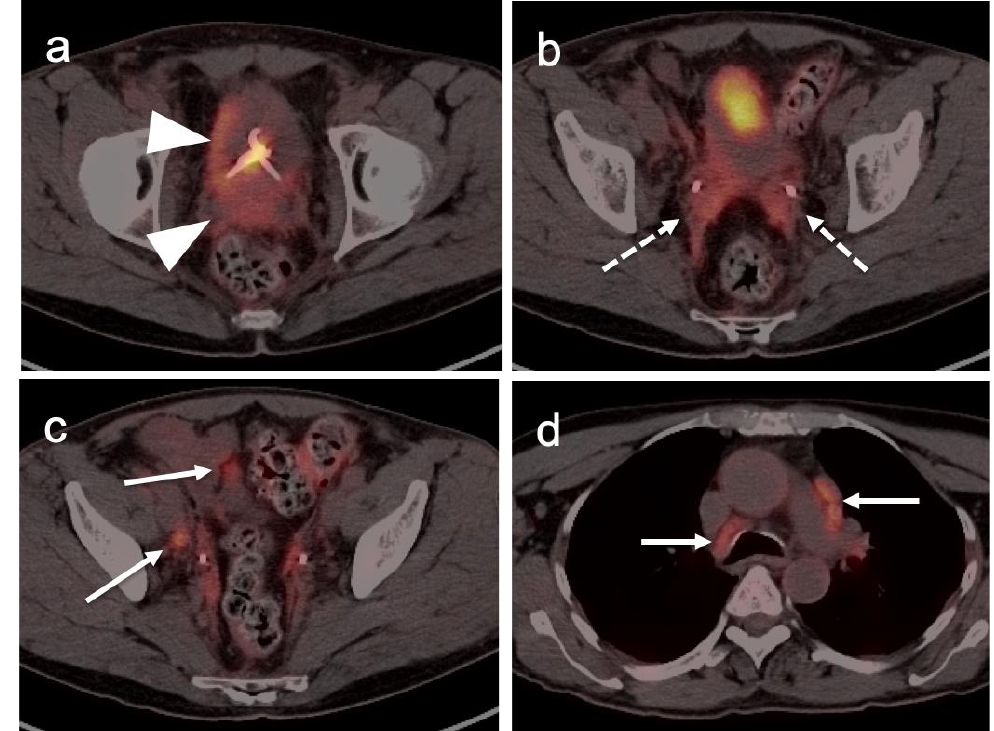
Figure 40. Lower tract urothelial cancer with metastatic disease shown on axial FDG PET-CT images. ( a ) The primary tumor is hypermetabolic (white arrowhead). ( b ) There is diffuse infiltrative spread into the seminal vesicles and mesorectal fascia (dashed white arrows). ( c ) There are multiple hypermetabolic nodes in the pelvis and mesentery (white arrows). ( d ) There are multiple hypermetabolic mediastinal lymph nodes (biopsy proven metastatic, white arrows).